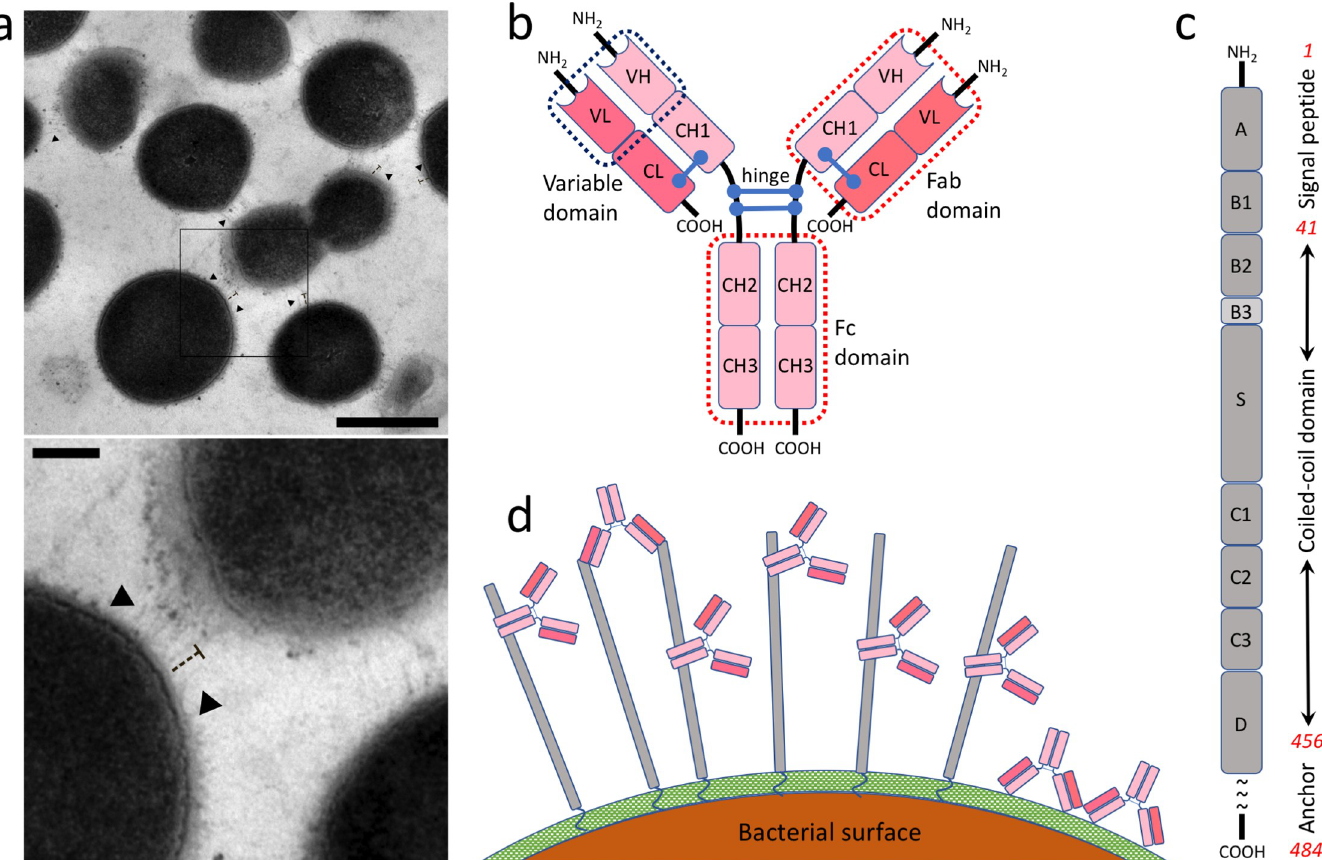
Fig 1. The schematic view of the studied system. (a) Electron microscopy image of the surface of bacteria representing the length of M1 protein. The scale bar in the larger image is 500 nm where in the zoom view below is 100 nm. Small arrows indicate the position of M1 proteins. (b) The general structure of human IgG. (c) Important domains of the M1 protein, including the hypervariable domain (A), fibrinogen binding domains (B1/B2), S-region, and albumin-binding domains (C1/C2/ C3). The coiled-coil region, the anchor, and the signal peptide are shown to the right specifying by the residue numbers in red. (d) IgG-orientations and -interactions with the M1-protein on the surface of GAS. Three major interactions are shown, including Fc- and Fab-mediated interactions, as well as opsonizing antibodies bound to the surface of the bacteria [16]. M1 is shown in gray while IgGs are in pink. The peptidoglycan layer on the surface of bacteria is shown in green.